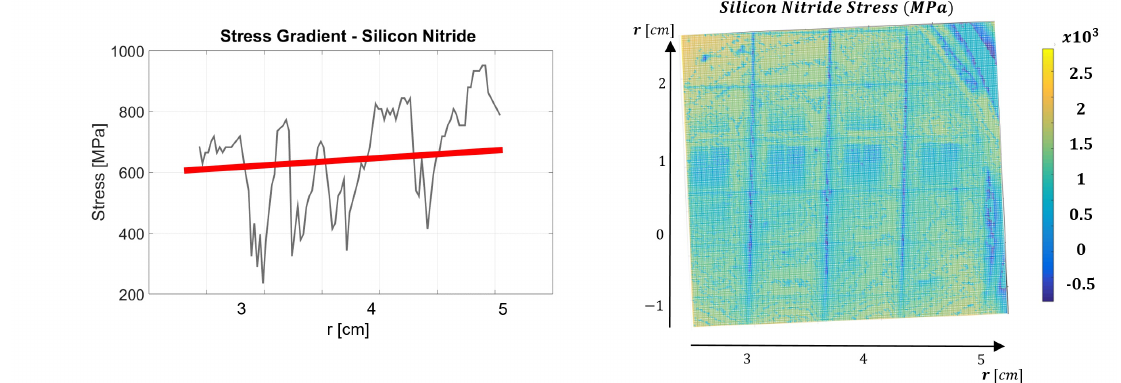
Figure 7. SDP along a radial line for the SN device (left) and estimated surface stress profile (right). Red line corresponds to stress value obtained from independent wafer-bow